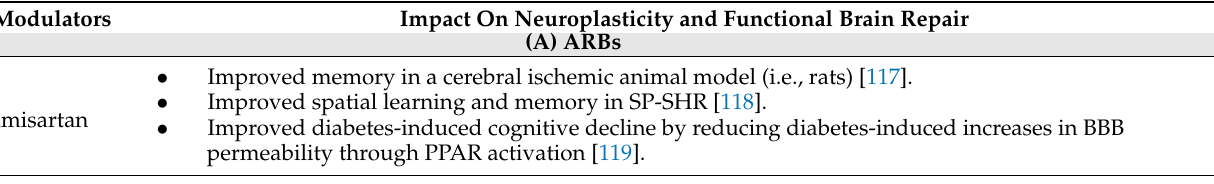
Table 1. Positive role of RAS modulators in molecular neuroplasticity and functional brain repair. Ras Modulators Impact On Neuroplasticity and Functional Brain Repair (A)